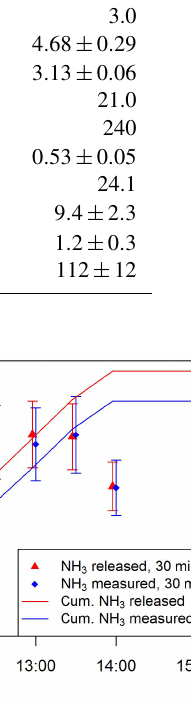
Figure 9. Released (red) and measured (blue) NH 3 emissions dur- ing artificial source experiment 3 on 19 June 2017. The measured emissions were quantified using the concentration difference of the miniDOAS systems MD2 and MD5 and the corresponding mod- elled bLS dispersion coefficient. The error bars indicate the uncer- tainty of the artificial source (Sect. 3.3.2) and from the measured emissions (bLS dispersion modelling; Sect.